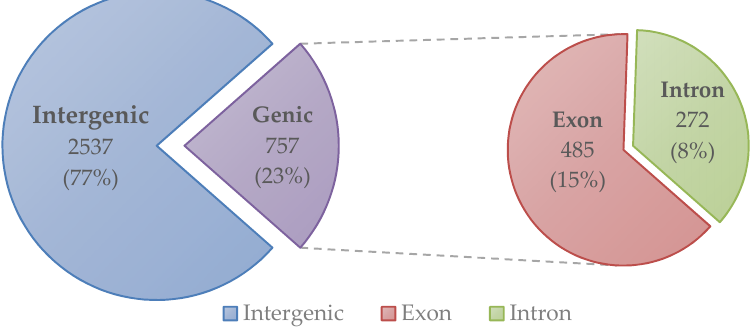
Figure 5. Number and percentage of SNP and Indel occurring in both T 1 and T 3 transgenic Chinese cabbage plants located in genic and intergenic regions.